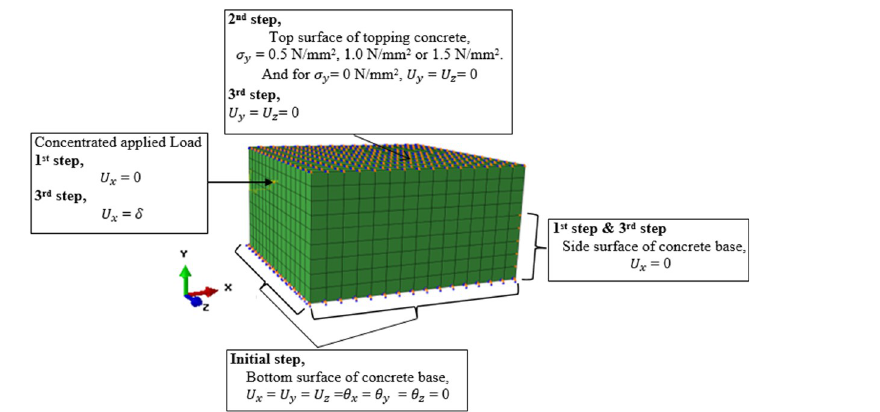
Fig 7. Evolution of the boundary conditions to simulate the loading